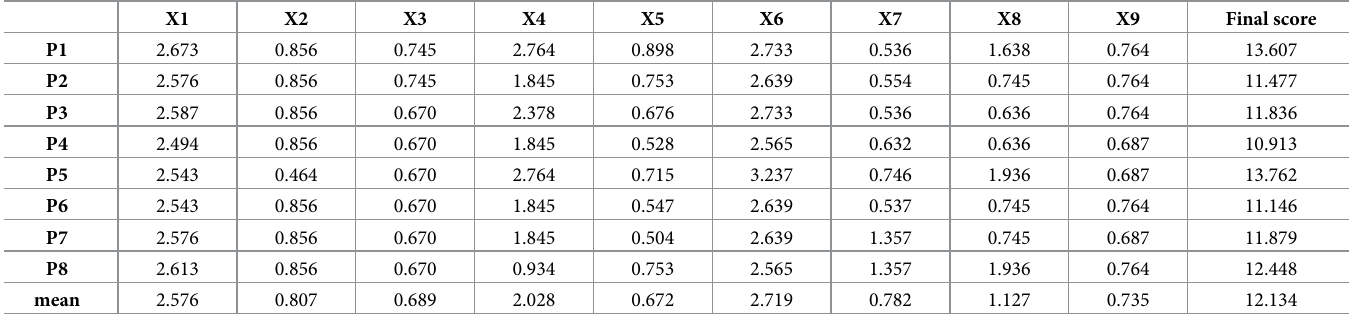
Table 8. Policy sample score